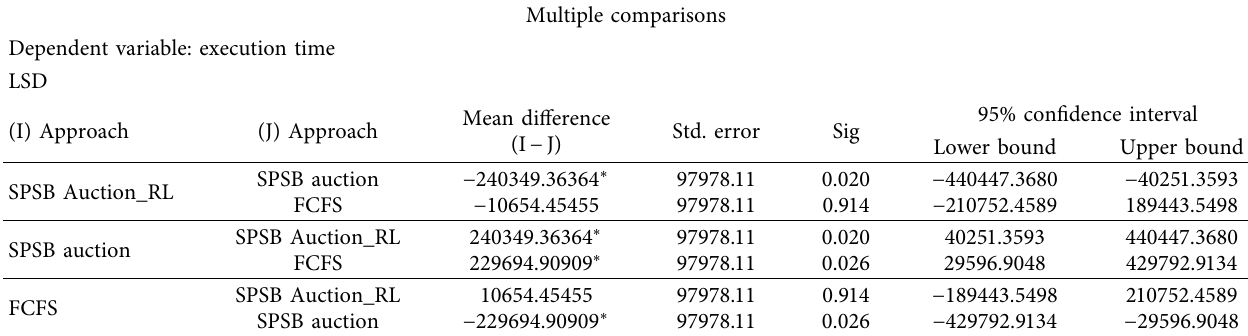
Table 5: Pairwise comparison of runtime values for diferent methods obtained from the ANOVA test. Multiple